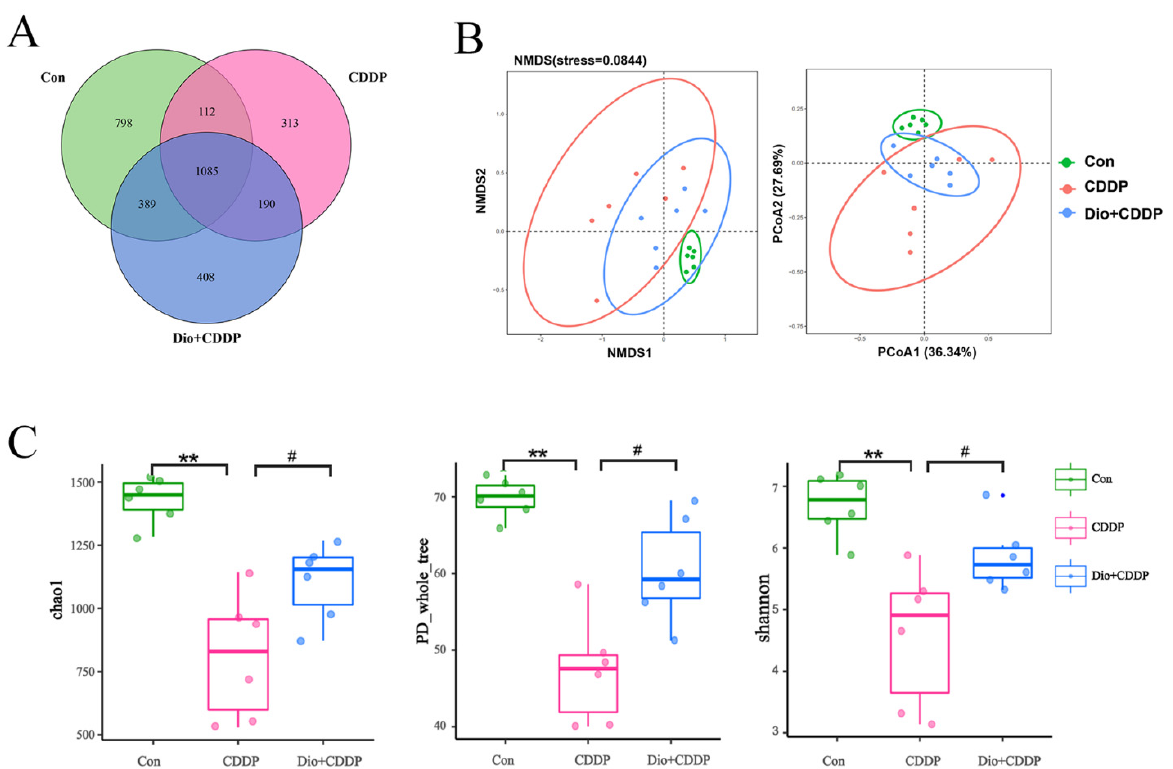
Figure 6. Effects of Dio administration on gut microbiota in CDDP-induced mucositis rats. ( A ) Venn diagram showing the overlap of OTUs identified in the gut microbiota among the three groups. ( B ) NMDS analysis and PCoA analysis of the three groups based on weighted UniFrac distances. Each plot represents one sample. ( C ) α -Diversity indicated by the chao index, PD_whole_tree index, and Ace index. All values were expressed as Mean ± S.D. ** p < 0.01 vs. control group, # p < 0.05 vs. CDDP